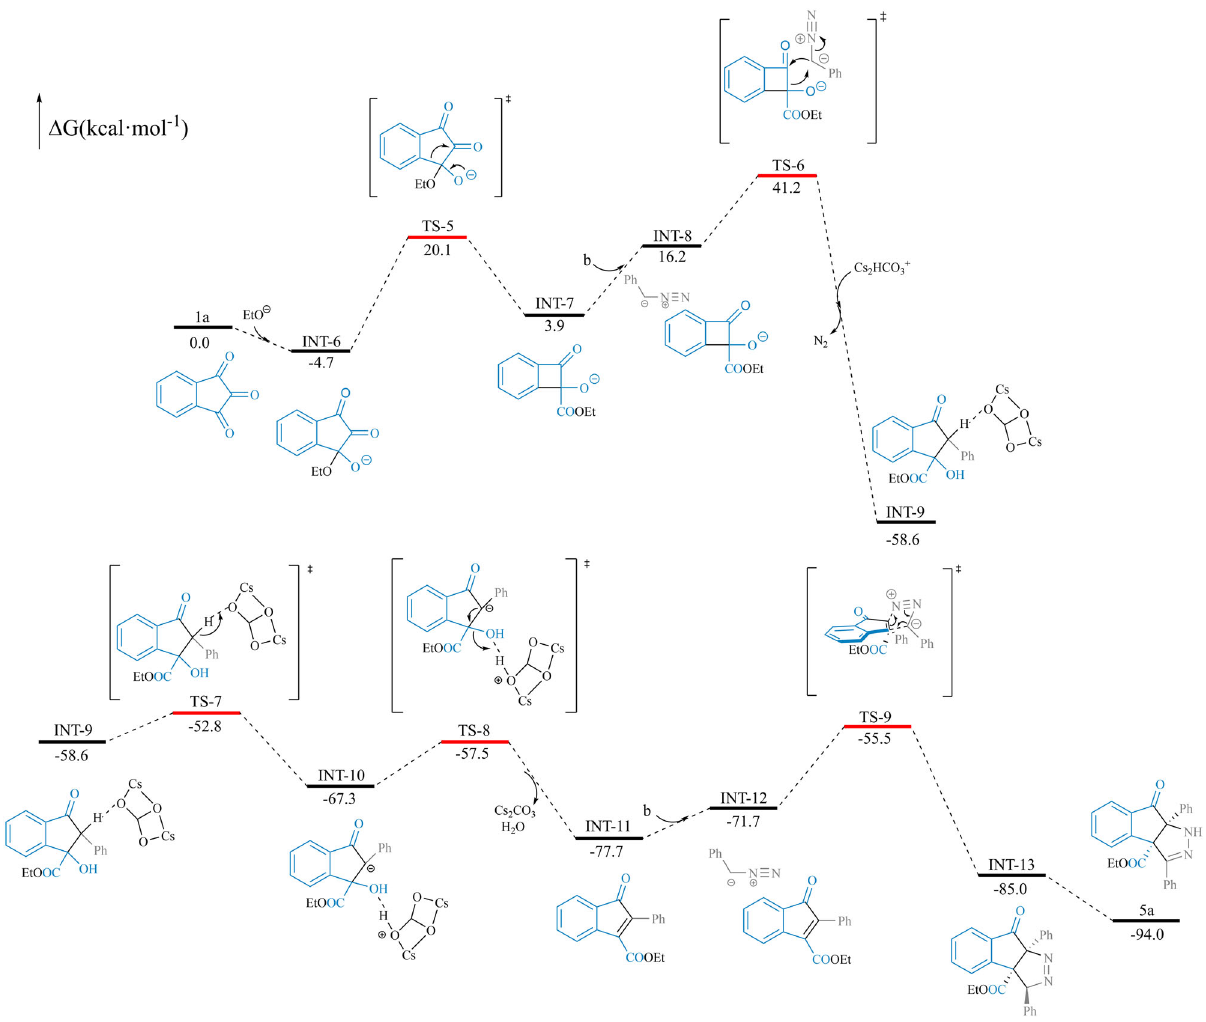
Fig. 8 Calculated reaction pathways and free energy pro fi les for the regioselectivity of the ring-expansion process in ethanol solvent. DFT calculations were performed with B3LYP-D3(BJ)-SMD(ethanol)/[other:6-311 ++ G(d,p);Cs: Lanl2DZ] //B3LYP-D3(BJ)/[other: 6-31G (d); Cs: Lanl2DZ] (for details see SI, Table